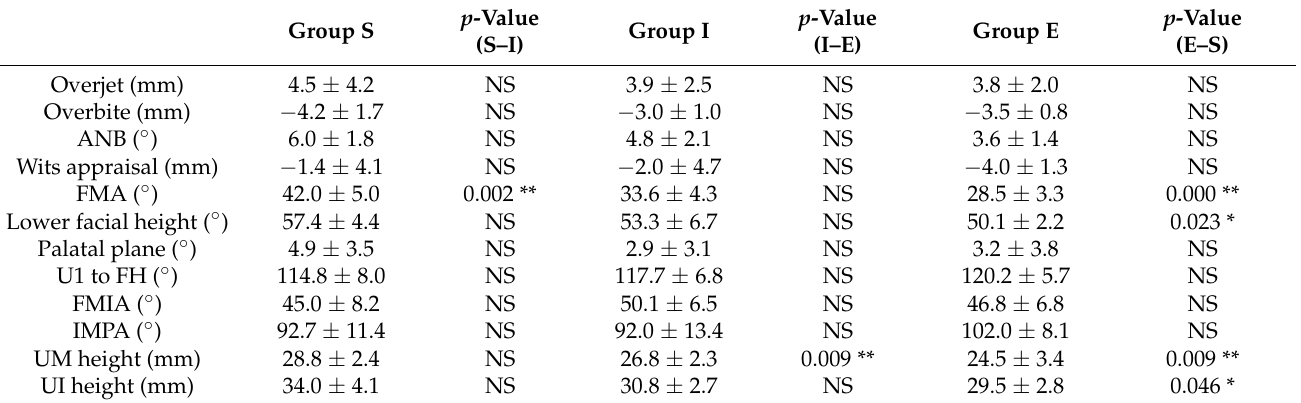
Table 2. Comparison of pre-treatment mean values among the three